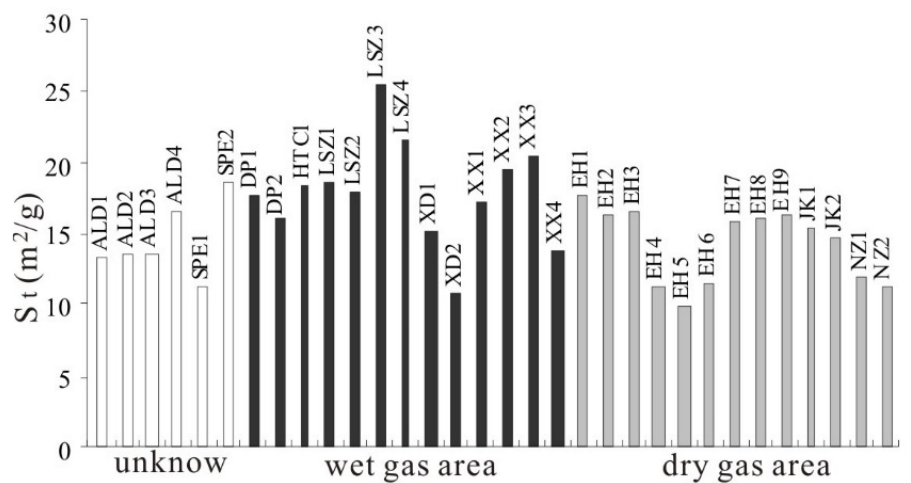
Figure 4. Histogram of total pore-specific surface area.